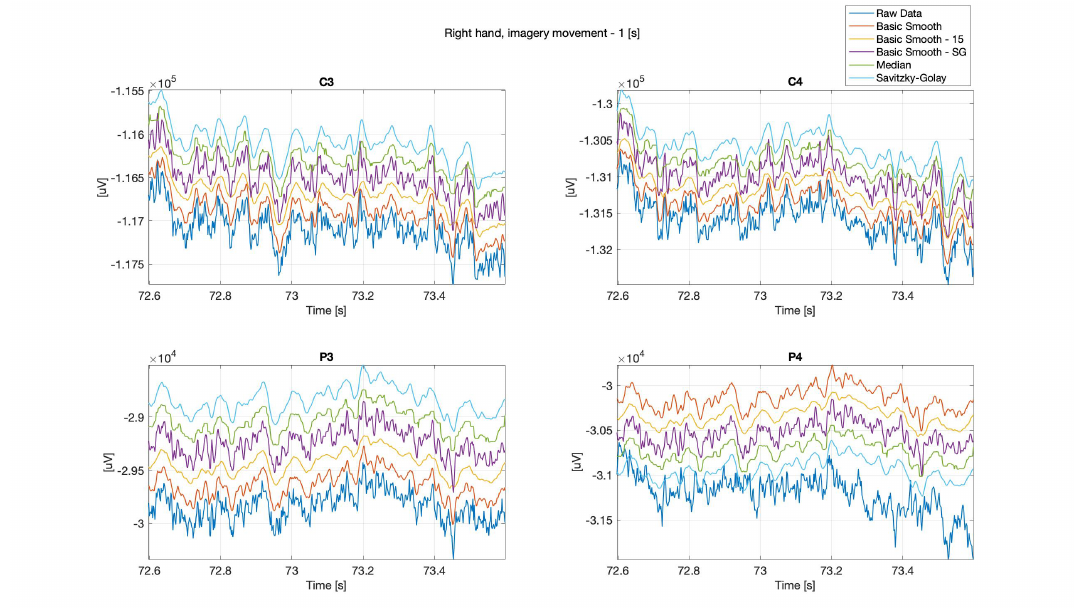
Figure 8. Right hand, imagery movement, C3, C4, P3 and P4